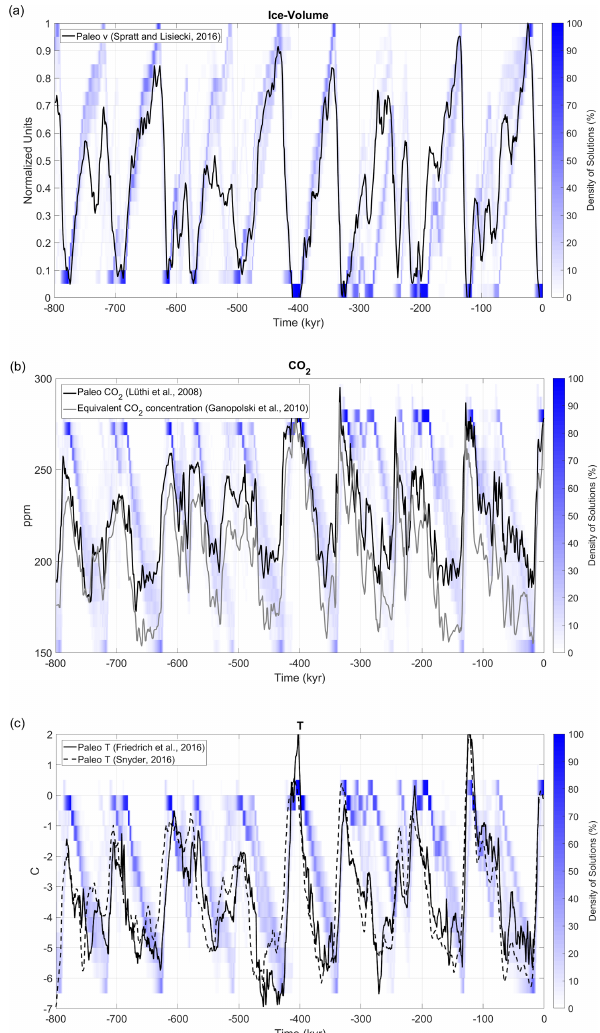
Figure 1. Paleovalid solutions and paleoclimatic records in the pe- riod [ − 800, 0kyr]: (a) global landmass ice volume (normalised to unity); reconstruction (black line) from Spratt and Lisiecki (2016). (b) Atmospheric CO 2 concentration (ppm), paleorecord (black line) from Lüthi et al. (2008), and equivalent CO 2 concentration from Ganopolski et al. (2010) (grey line). (c) Global mean surface tem- perature anomaly (C); paleorecords from Friedrich et al. (2016) (solid black) and Snyder (2016) (dashed). Blue shaded areas rep- resent the density of Paleovalid solutions per unit of phase space (units are 1kyr for time, 0.05 for ice, 7ppm for CO 2 , and 0.5 ◦ C for temperature).